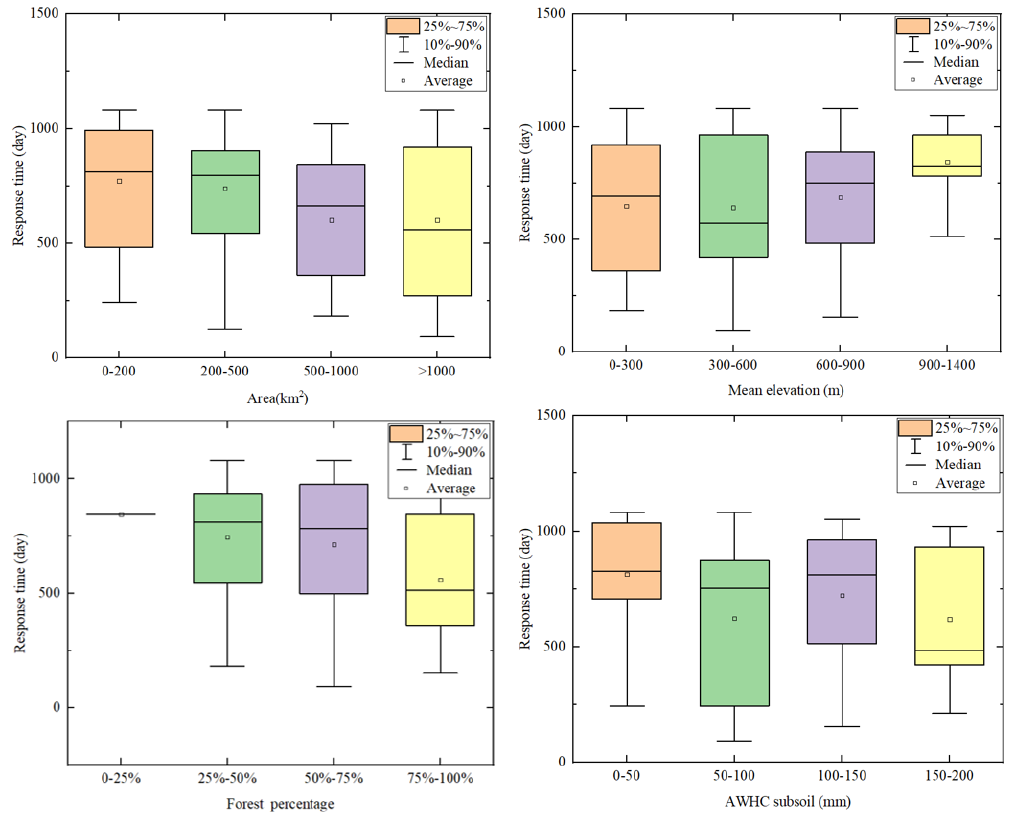
Figure 15. The potential connections between the response time and catchment